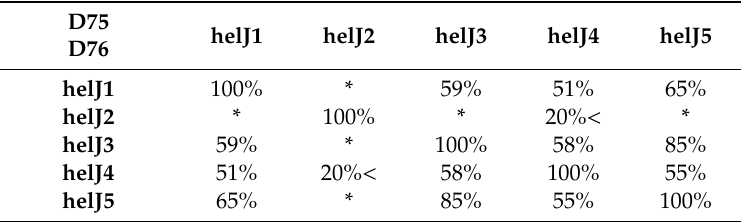
Table 3. Similarity between the amino acid sequences of the helJ1 , helJ2 , helJ3 , helJ4 , and helJ5 proteins in L. helveticus D75 and